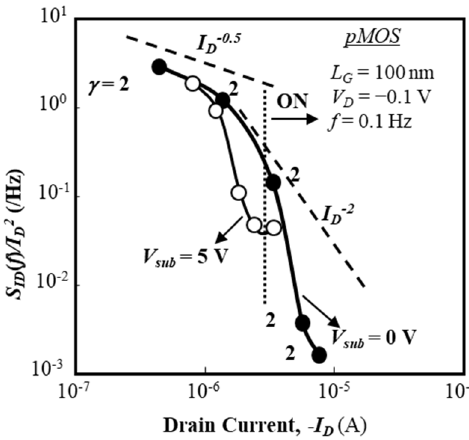
2 ) of drain current as a function ( f ) / I 2 ( ) D S f I ) of drain current as a D D I D